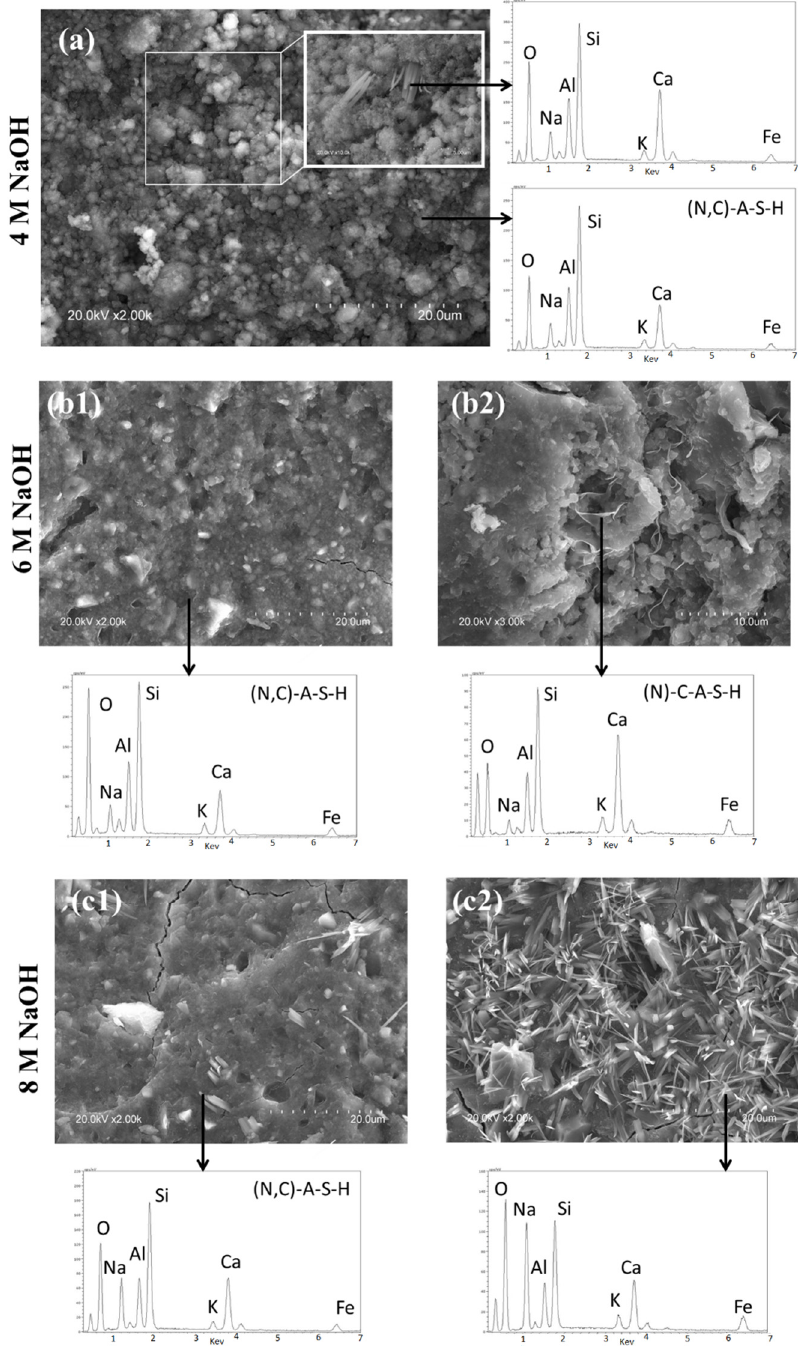
Figure 6. Twenty-eight day SEM micrographs and EDX spectra for ( a ) 4 M, ( b ) 6 M ( b1 , b2 ) and ( c ) 8 M ( c1 , c2 ) NaOH-activated pastes.